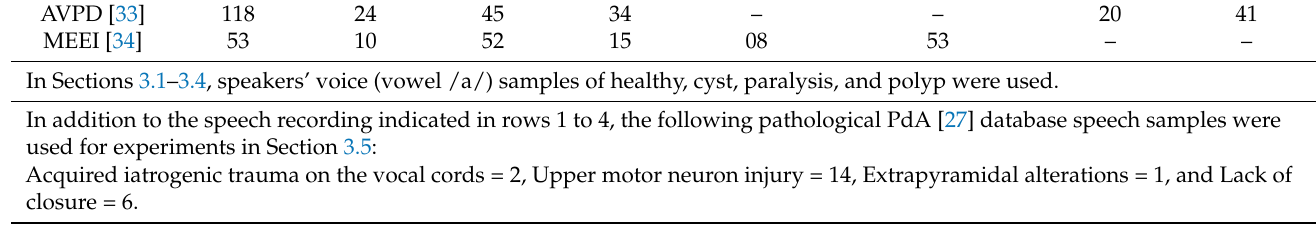
Table 2. Characteristics of the